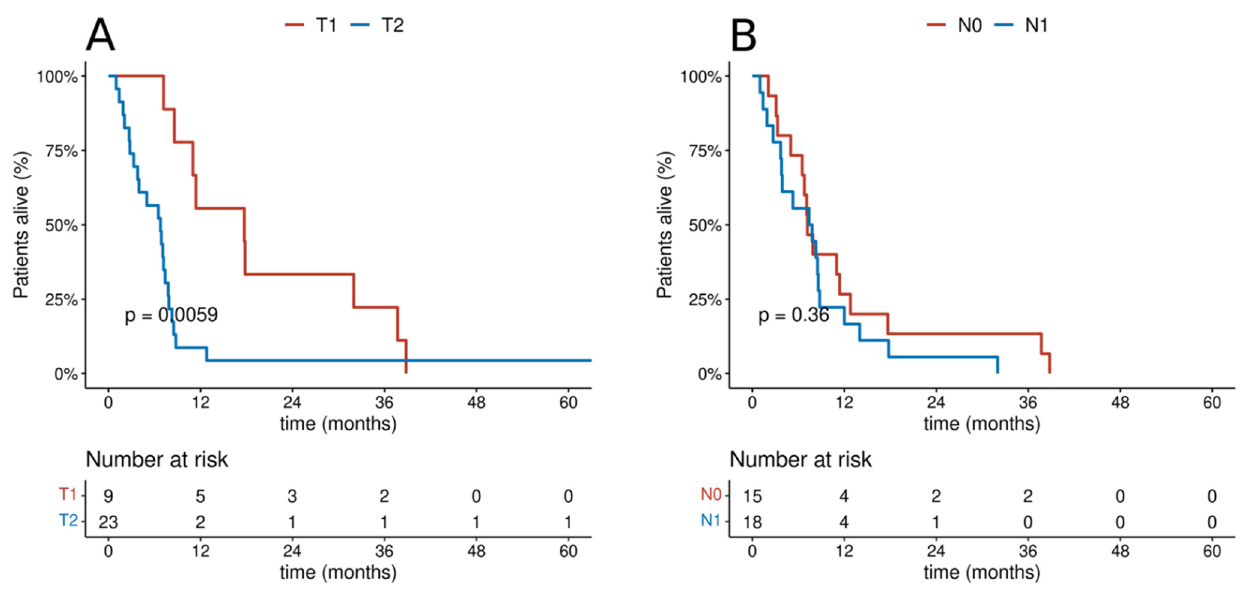
Figure 5. Cumulative probability of overall survival in the group of patients receiving palliative treatment according to categories: ( A ) T; ( B ) N. According to multivariate analysis, we identified also the following prognostic factors for overall survival: gender, histological type of tumor and performance status in radically treated patients, and histological type of tumor for patients treated palliatively. In the group of patients receiving palliative treatment, gender and performance status had no effect on